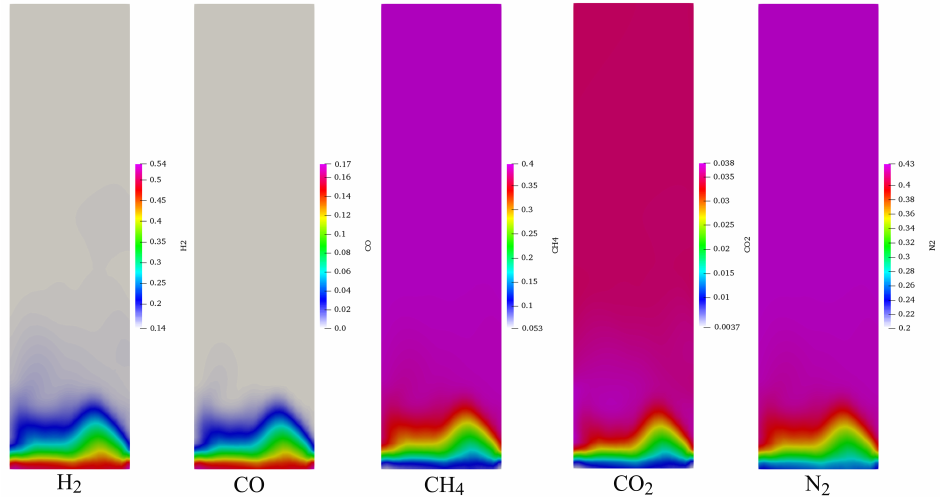
Figure 2. Numerical results of instantaneous distribution of gas species mass fraction. N 2 is used as a balance gas. The mass of catalyst is 70